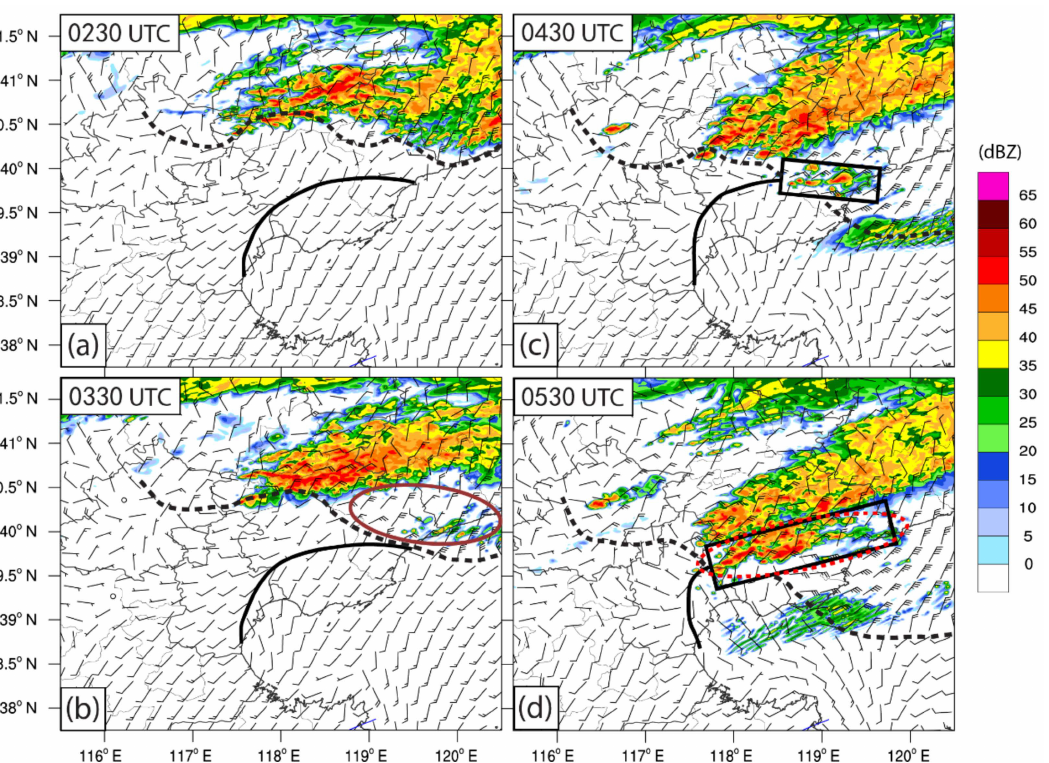
Figure 7. ( a – d ) Simulated composite reflectivity (shading, units: dBZ) and wind field (full and half barbs represent 4 and 2 m s − 1 , respectively) at 10 m height above the ground on 31 July 2010. The black solid lines indicate the locations of the SBF, and black dashed lines denote the locations of the GF. The black rectangle area indicates the merging area. The solid brown ellipse shows the area where the convective system significantly weakened and (or) dissipated. The dotted red ellipse indicates the area where convections initiated and (or) intensified due to the merger of the SBF and GF. The specific time is shown in the upper left corner of each